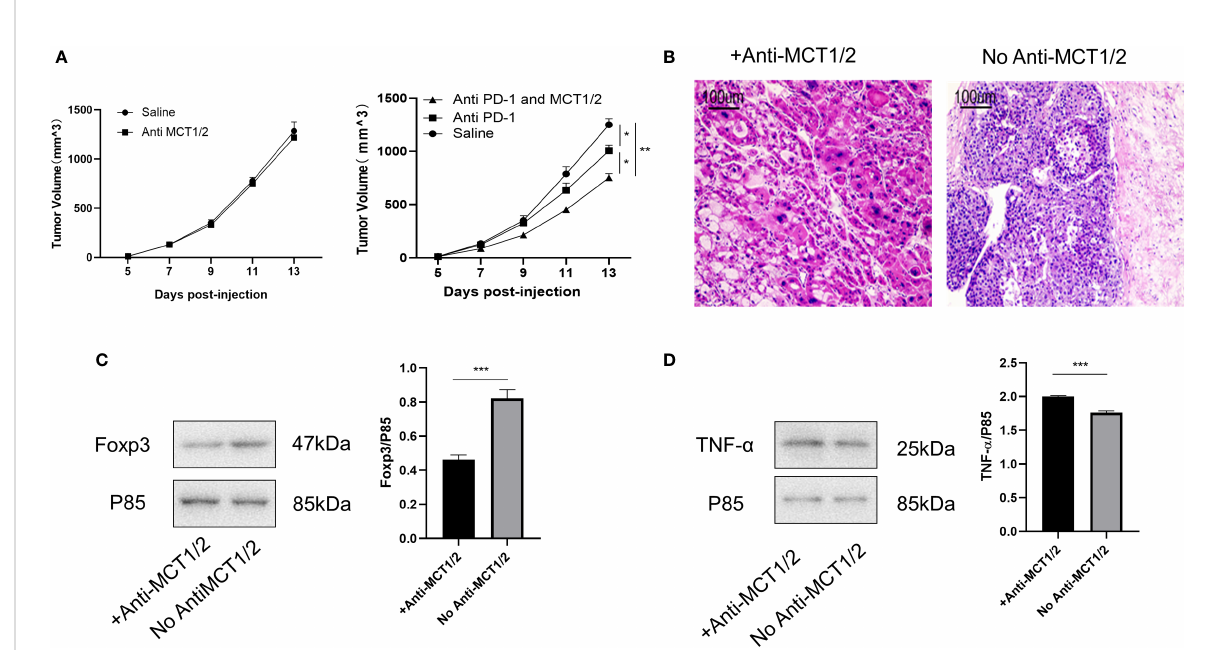
FIGURE 7 Co-treatment of MCT and PD-1 inhibitors reduced tumor growth by downregulating Tregs and upregulating anti-tumor cytokine expression. (A) Tumor growth in different groups post-injection (left Rag1 − / − mice and right C57L/B6 mice). (B) HE staining of tumor from different groups. (C, D) Western blot for expression of Foxp3 and TNF- a in different groups. The result is representative of three independent experiments. Data were mean ± SD of three independent experiments (each group, n=3). *p < 0.05; **p < 0.01;